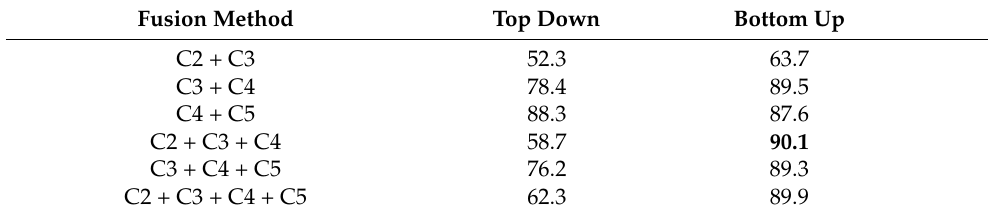
Table 5. Detection results of medium-scale ships with different fusion